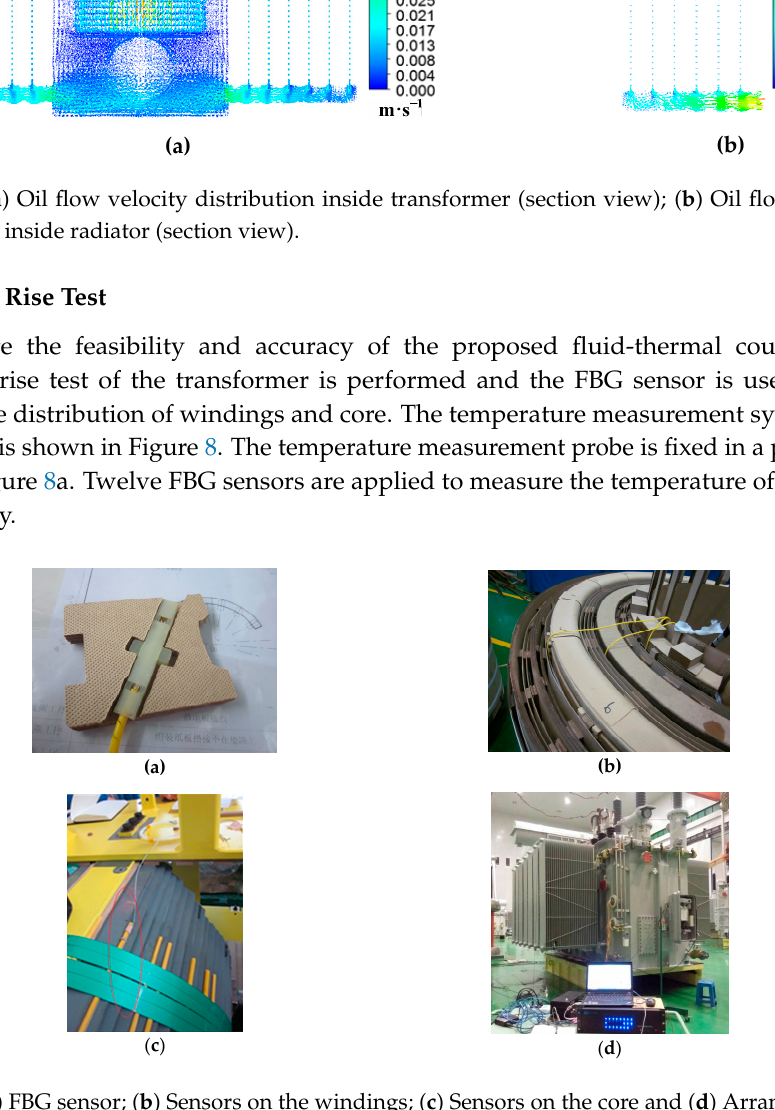
Figure 8. ( a ) FBG sensor; ( b ) Sensors on the windings; ( c ) Sensors on the core and ( d ) Arrangement of temperature rise test.